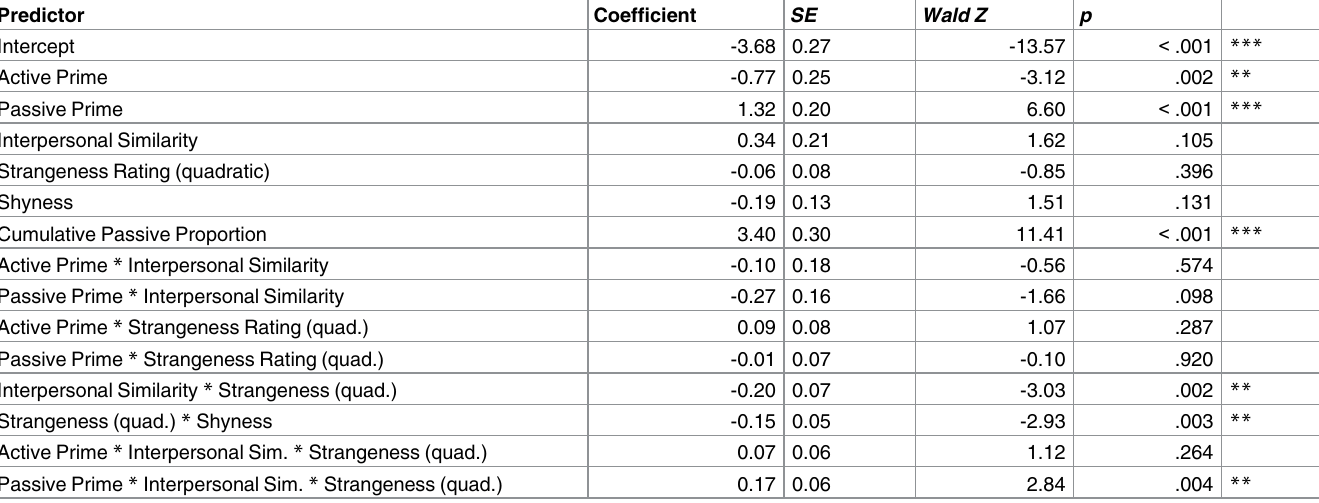
Table 4. Summaryof the fixed effectsin the mixed logit model for the response choices based on prime structure per